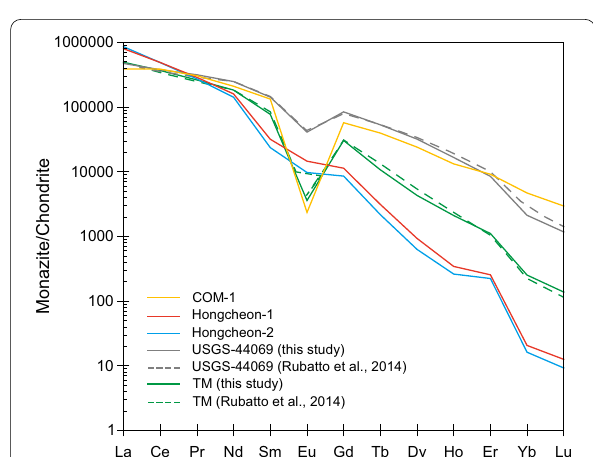
Fig. 2 Chondrite‑normalized rare earth element patterns of the monazite reference materials. The chondrite value was obtained from McDonough and Sun